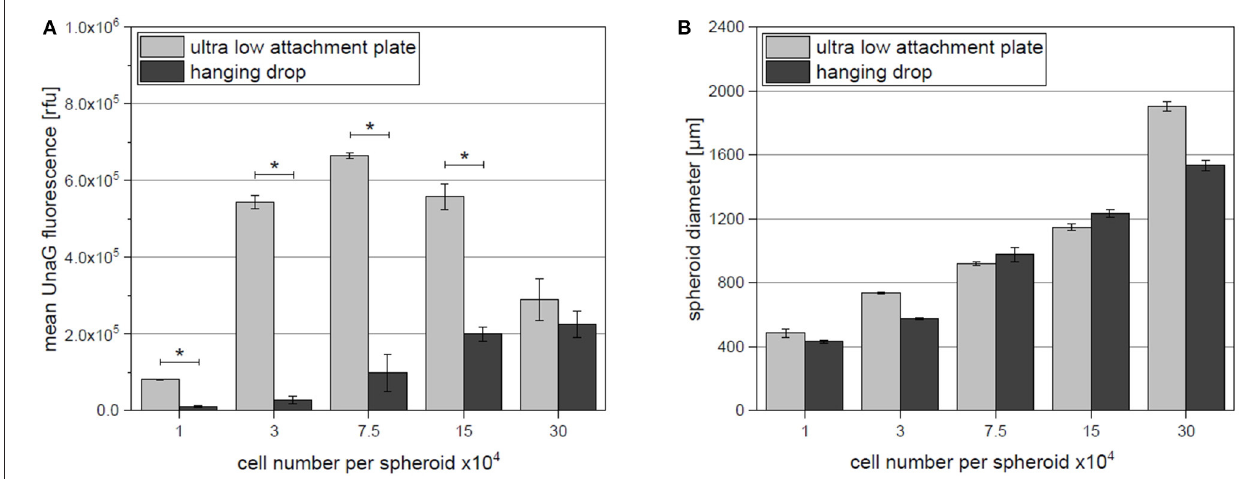
FIGURE 3 | (A) Mean single cell fluorescence determined by flow cytometry. For both fabrication platforms (ultra low attachment plate and hanging drop) hypoxia reporter hAD-MSCs were cultivated as spheroids and dissociated to facilitate single cell analysis. (B) Respective spheroid diameters as obtained by both fabrication platforms. Data represent the mean ± SD for a 3-fold determination. * p < 0.05.